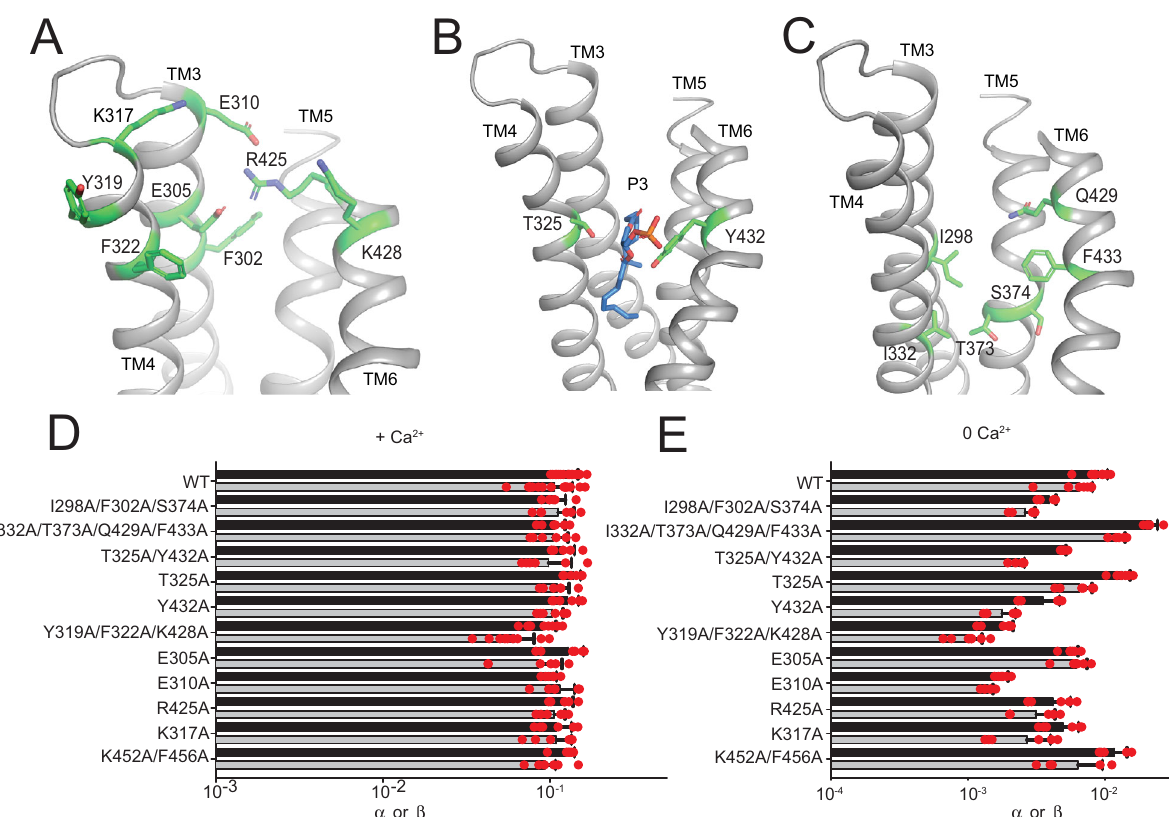
Fig. 3 Functional role of groove-lining residues in lipid scrambling. A – C Residues lining the extracellular vestibule ( A ), coordinating P3 ( B ) and lining the central constriction ( C ) are shown as green sticks. D , E Forward ( α ) and reverse ( β ) scrambling rate constants of single and multiple alanine substitutions at the indicated positions. Bars are average values for α (black) and β (gray) determined from n = 5 – 16 independent determinations from N = 2 – 8 independent preparations, error bars are S. Dev., and red circles are values from individual repeats. Source data is available in the Source Data fi